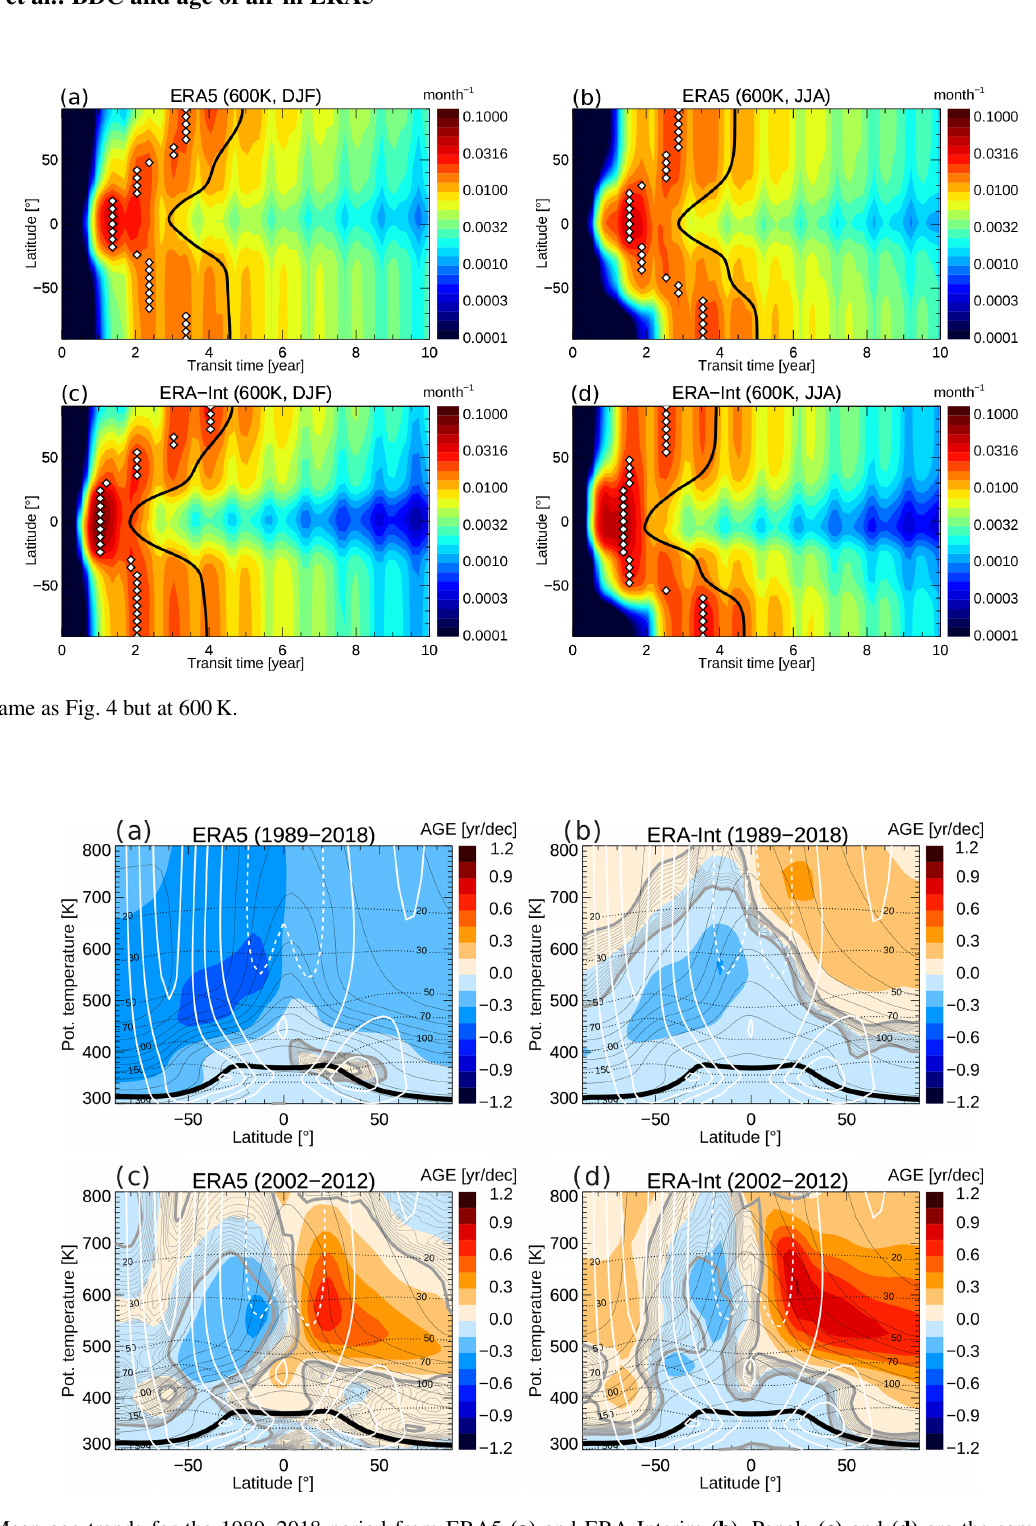
Figure 6. Mean age trends for the 1989–2018 period from ERA5 (a) and ERA-Interim (b) . Panels (c) and (d) are the same but for the 2002–2012 period. Black contours (solid) show the climatological mean age, the thin dashed black lines show pressure levels, the white contours show zonal wind (in ± 10m/s steps; easterly wind dashed), and the thick black line shows the tropopause. The significance of the linear trend, measured in multiples of the standard deviation σ , is shown as grey contours (the 2 σ contour is thick, and the contours then decrease with a 0.2 step – shown by thin